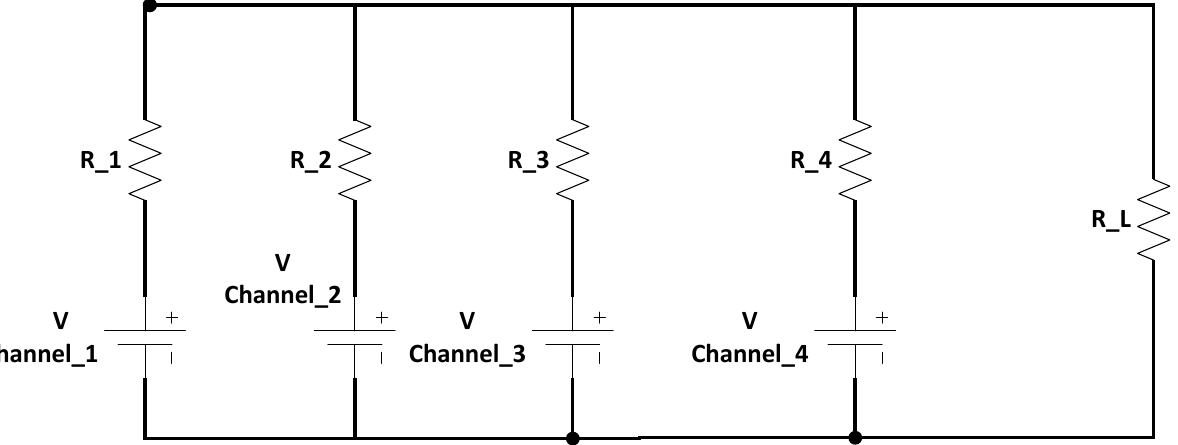
Figure 8. Equivalent quad-band circuit based on Millman’s